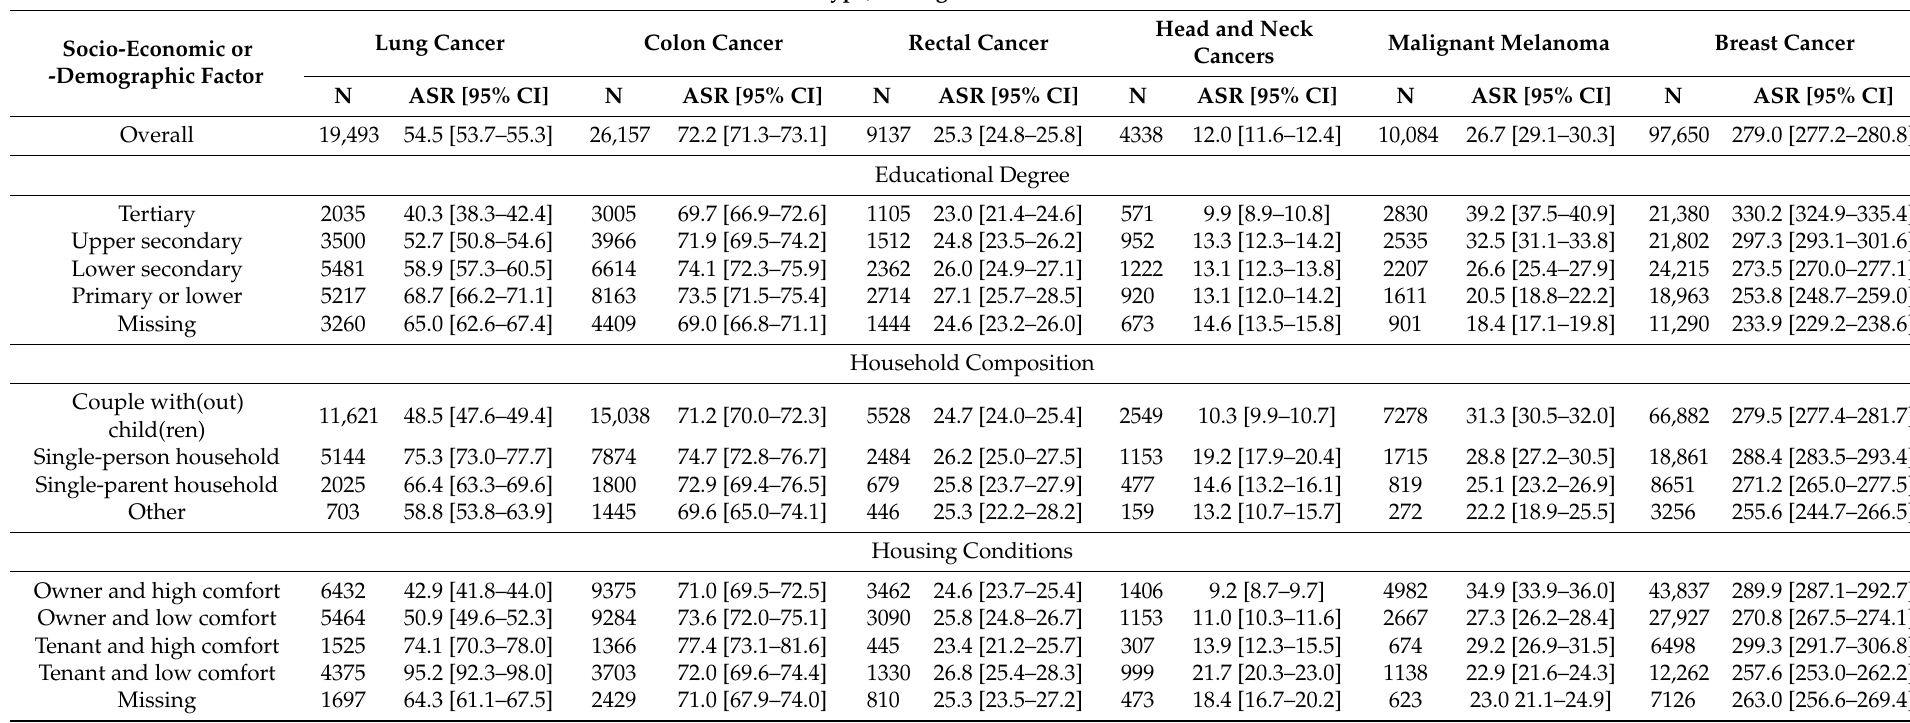
cancer type, among women over